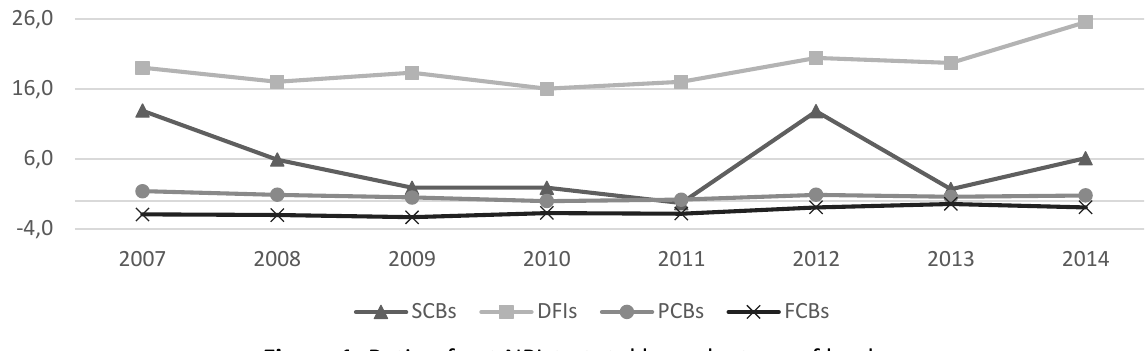
Figure 1. Ratio of net NPL to total loans by type of banks